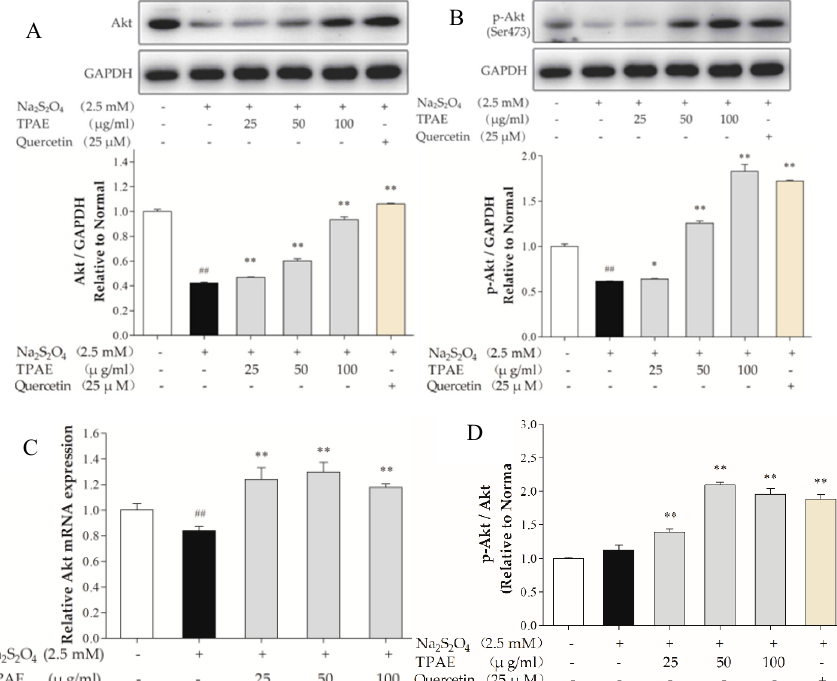
Figure 3. Effects of TPAE on PI3K/Akt signaling pathway. The protein expression of Akt ( A ), p-Akt (Ser473) ( B ), and GAPDH was measured by western blotting. Quantitative analyses of Akt normalized to GAPDH (A), p-Akt (Ser473) normalized to GAPDH ( B ) in protein expression were evaluated; ( C ) The relative mRNA expression of Akt was detected by qRT-PCR; ( D ) Quantitative analyses of the ratio of p-Akt to Akt in protein expression was evaluated. Values were represented as mean ± SD (n = 3, each group). The results were representative of three independent experiments. # p < 0.05, ## p < 0.05 vs. normal group; * p < 0.05, ** p < 0.01 vs. H/R group.